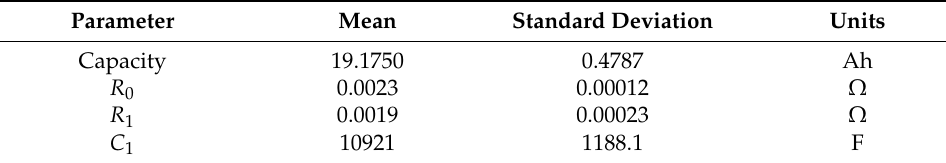
Table 2. Capacity and ECM parameters